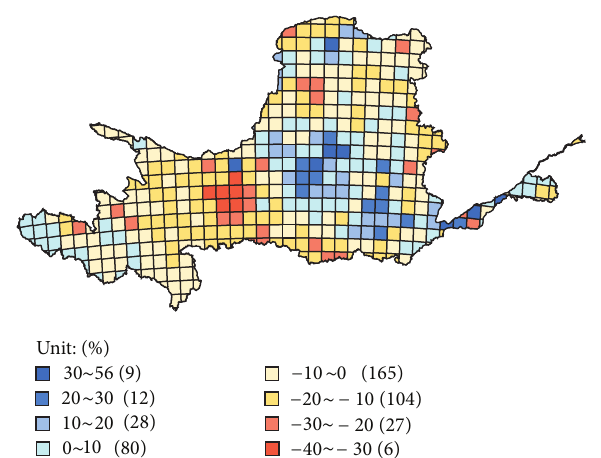
Figure 4: Variation in mean annual runoff simulated by bias- corrected RegCM3 data compared to that simulated by the observed data